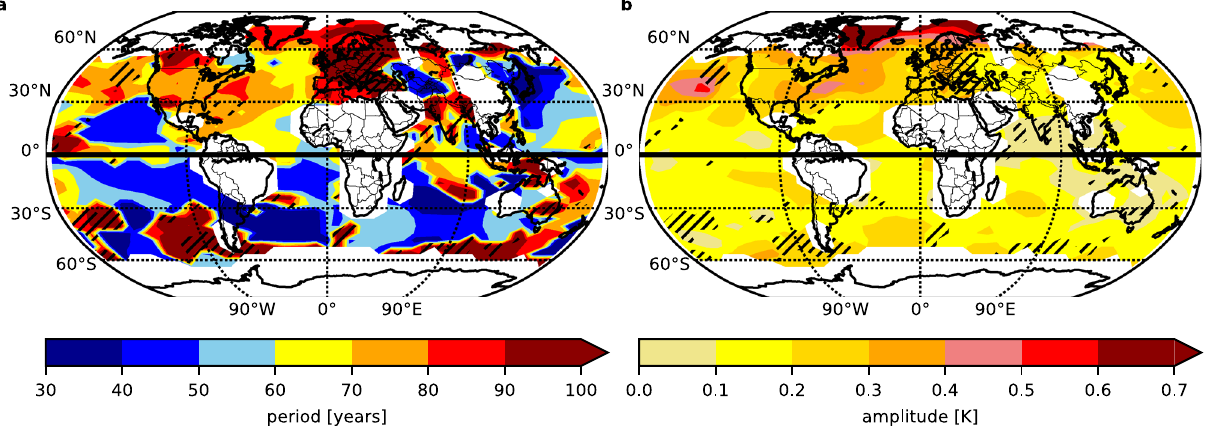
Figure 3. Global distributions of periods and amplitudes for the strongest oscillation in the period range > 30 years. ( a ), ( b ) The data have been averaged in 8° × 4° longitude-latitude boxes. Only results for average values with full temporal coverage for all single data points have been considered. White areas show regions, where not enough or no data are available. The hatched areas mark region where the data were fitted